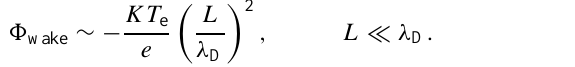
Fig. 11. Comparison of EFW and EDI data for an event with a spurious electric (cid:2)eld in the EFW data, this time from a dawn-dusk orbit, in the same format as in Figure 9.